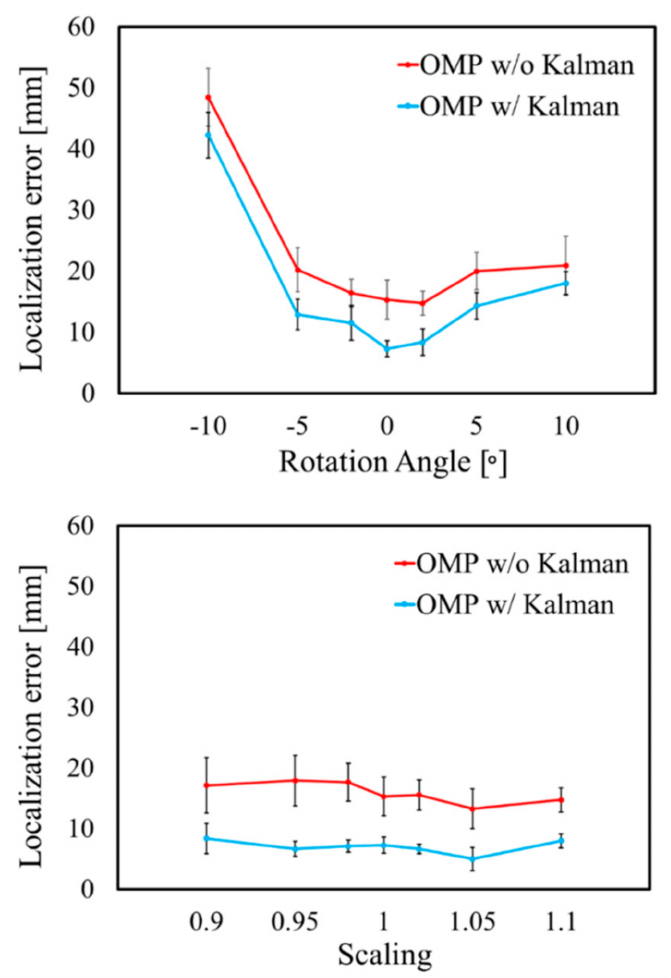
Figure 14. LE on R-wave for each rotation angle and scaling of heart. Error bars represent standard